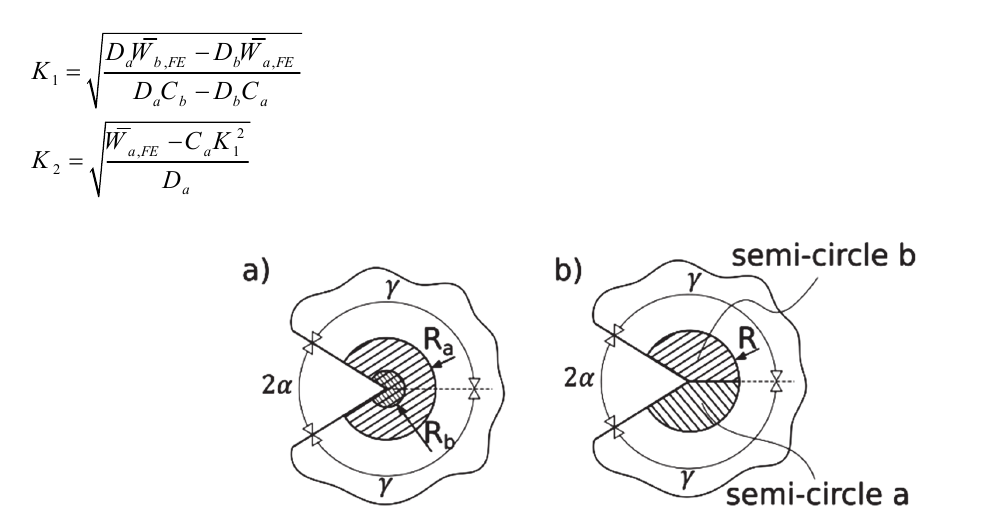
Figure 2: Control volumes in the Lazzarin et al. approach (a) and in the Treifi et al. approach (b). Treifi et al.